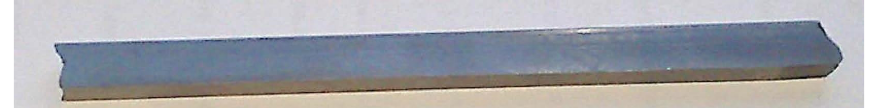
Figure 8: Te shape of the samples after the frst stage of deformation and surface treatment. Workpiece dimensions: thickness is 9mm, width is 10mm, and length is 175mm.